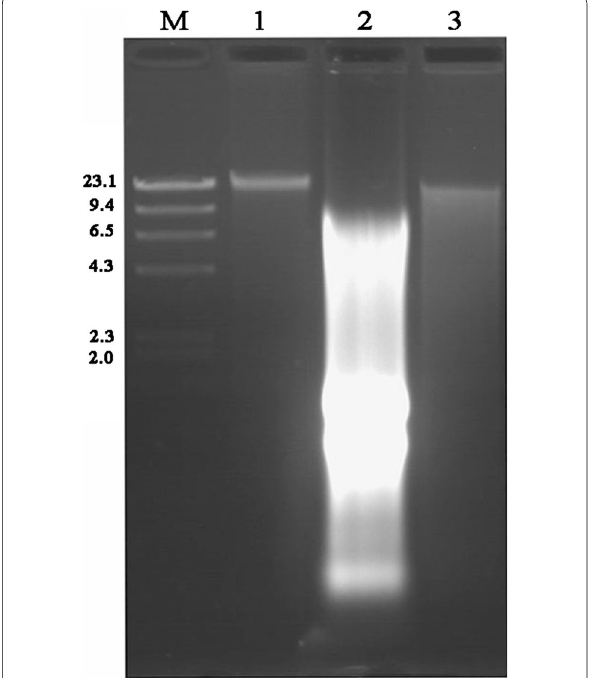
Fig. 2 Agarose gel electrophoresis of the genomic DNA extracted from the intestinal microflora of Cyprinus carpio var. Koi . Lanes: M